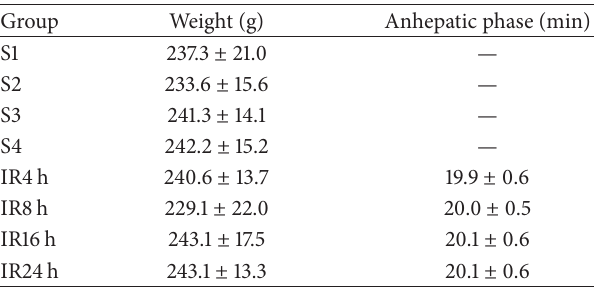
Table 4: Rat body weight and anhepatic phase duration time in studied